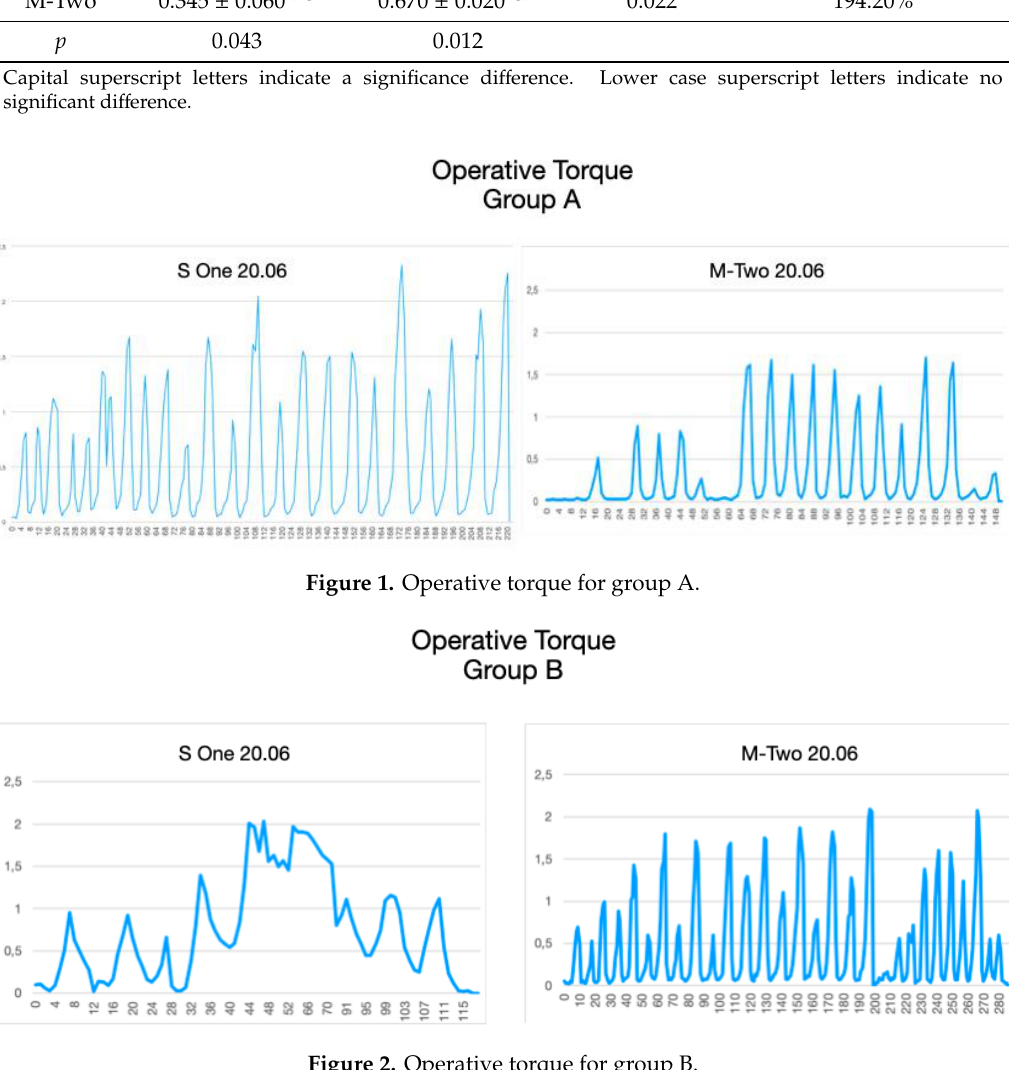
Figure 2. Operative torque for group B.